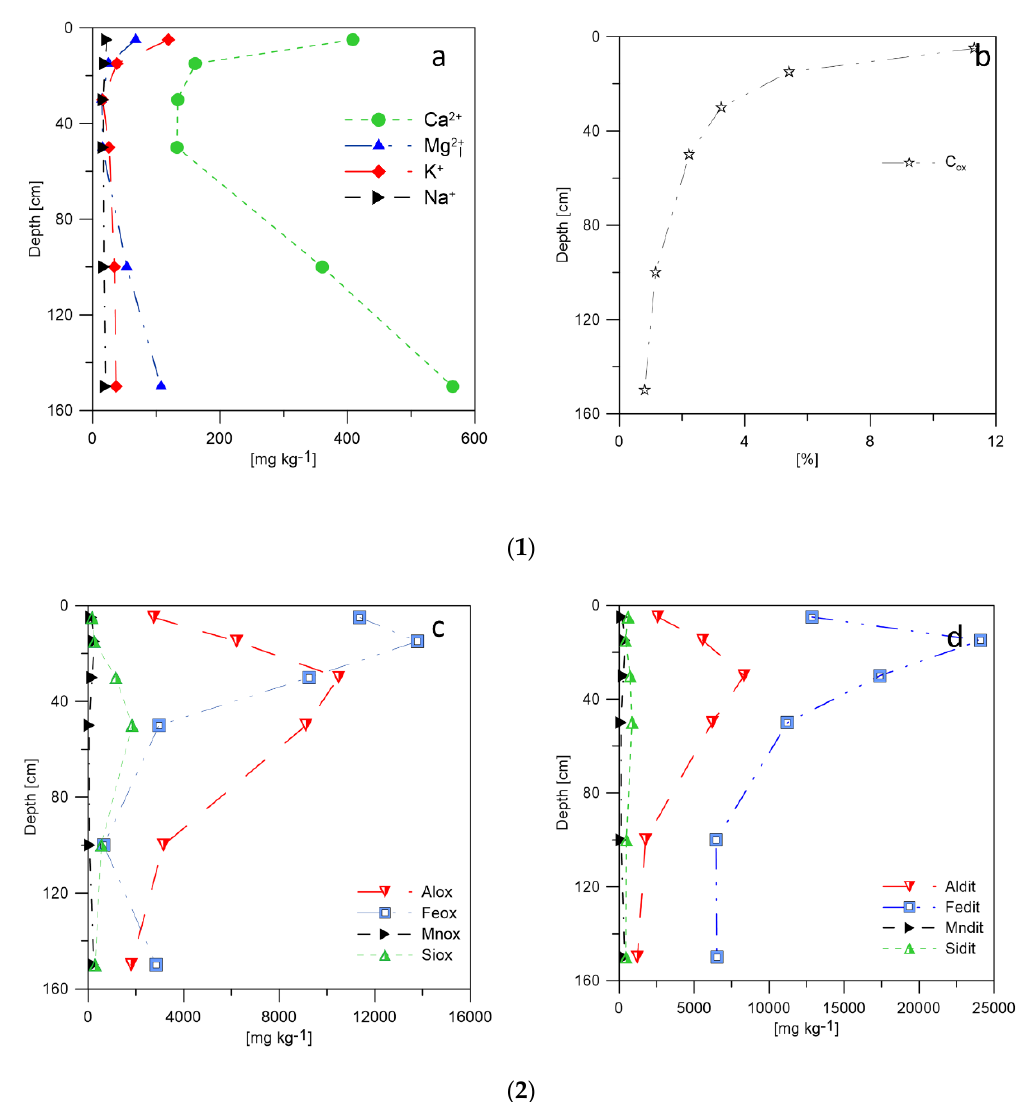
Figure 2. Vertical distribution in the soil profile of the soil chemical properties analysed in our study area. ( a , b ) were soil properties of external sources, and ( c , d ) were soil properties of pedogenic sources. ( 1 ). Soil chemical properties of external sources. ( 2 ). Soil chemical properties of pedogenic sources. Cations: Ca 2+ -Calcium, Mg 2+ -Magnesium, K + -Potassium, Na + -Sodium, Al ox ,Fe ox , Mn ox , Si ox -